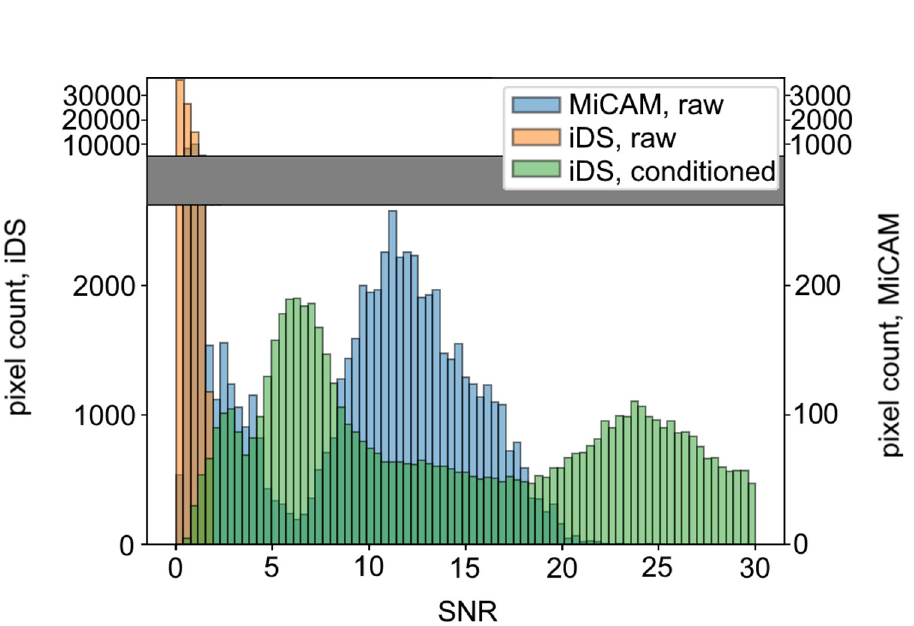
Fig 2. Histogram of SNR in recordings from mouse ventricles (n = 6). Orange represents SNR of the raw signal obtained by iDS, green represents SNR from the same pixels after signal conditioning, blue represents corresponding SNR of the raw signal obtained by MiCAM.